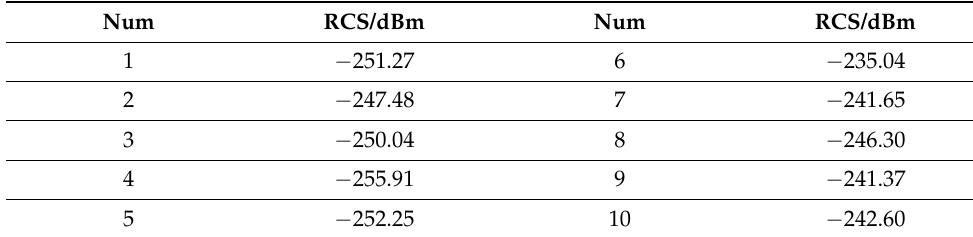
Table 1. The comparison with different sizes of cubes.